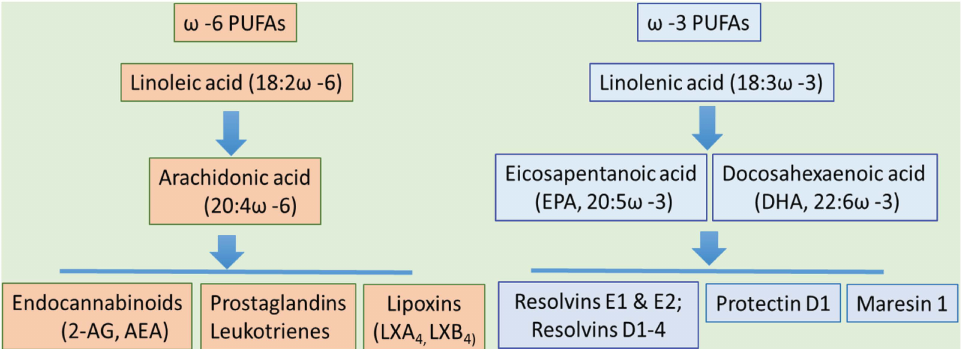
Figure 1. Omega ω -6 and ω -3 essential fatty acids and their metabolites. Abbreviations: AEA: N -arachidonoylethanolamine (anandamide); 2-AG: 2-arachidonoylglycerol; LXA 4 : lipoxin A 4 ; LXB 4 : lipoxin B 4 ; PUFA: polyunsaturated fatty